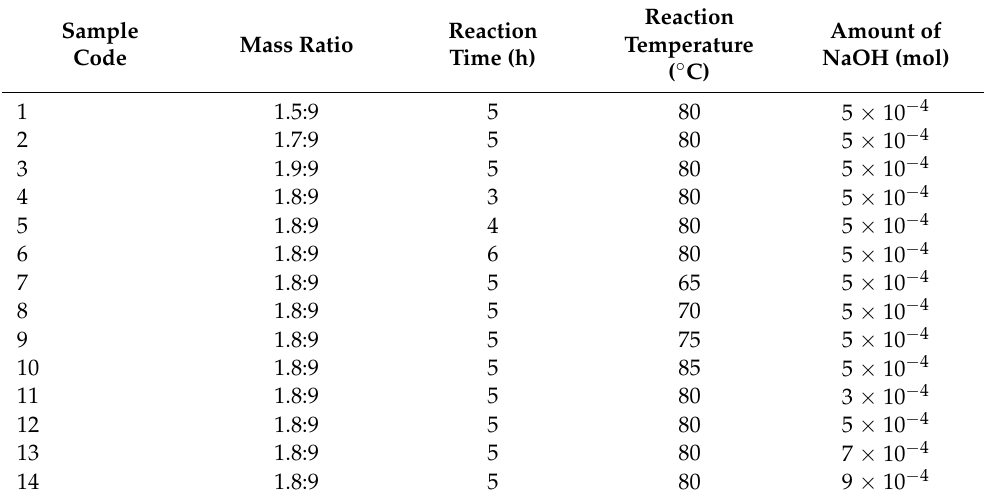
Table 1. Comparison of the apparent viscosity of unmodified CMC and CMC modified under different conditions in pure water